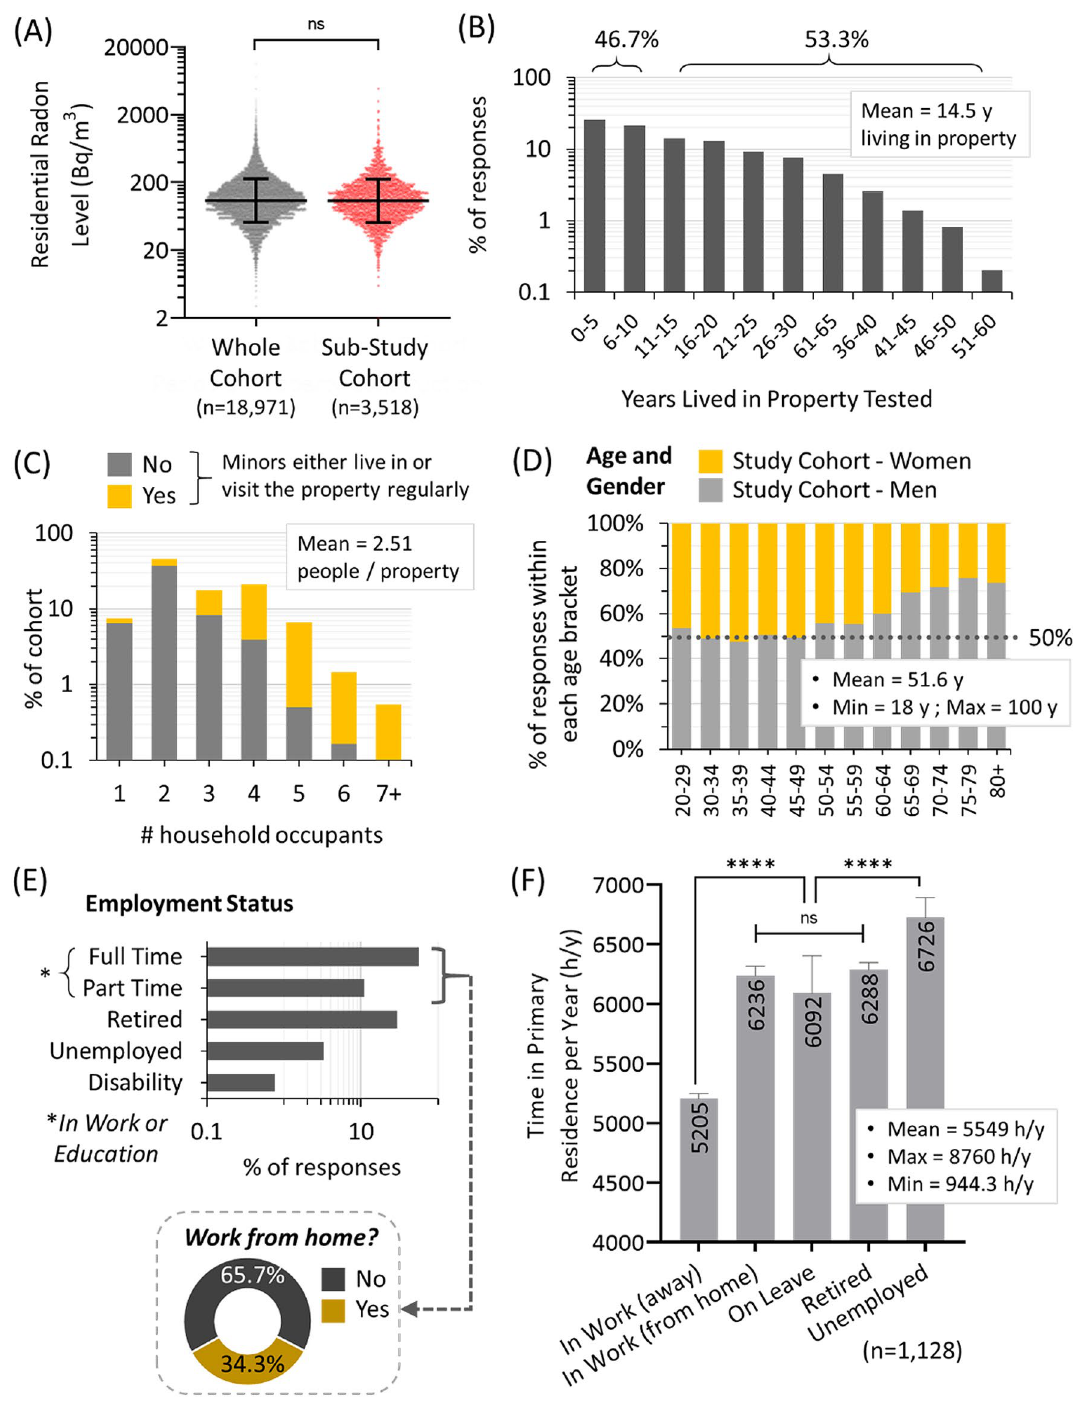
Figure 1. Residential occupancy status, age and employment status of the radon-tested cohort. ( A ) The measured long term residential radon level for the entire Canadian study cohort (grey: n = 18,971) was compared to the sub- study (red: n = 3,518), i.e. participants who also provided demographic data. The radon test outcomes for the sub- study reflected the entire cohort, with no significant difference in the geometric mean radon (black lines ± geometric standard deviation) or data distribution between sets. All remaining data refers to the sub-study cohort unless otherwise indicated. ( B ) The amount of time each participant indicated they had lived in the radon-tested property at the time of testing. ( C ) The total number of occupants living full time in the radon-tested property, with yellow indicating properties where there are pregnant occupants or minors (ages 0–17) living or visiting regularly, and grey sections indicating homes where all occupants are 18 or more years of age. ( D ) Reported gender balance by age group of the cohort. ( E ) The reported employment status of the cohort. The inset pie chart shows the percentage of those in full or part time work who indicate working from home either part or all of the time. ( F ) The geometric mean of the amount of time each participant reported spending per year in the primary residence, as a function of reported occupation status, showing 2-way ANOVA analysis of indicated pairwise comparisons. **** p <